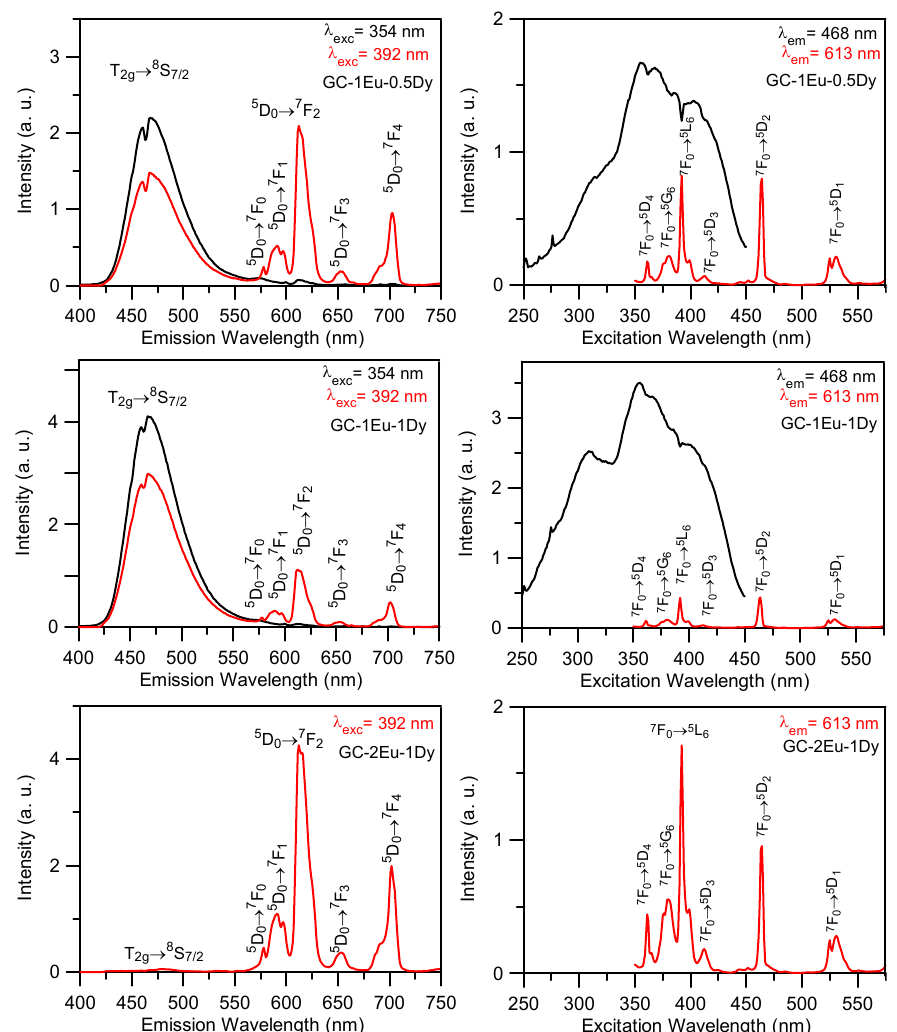
Figure 7. ( Left ) Room temperature emission spectra obtained under excitation at 354 nm (Eu 2+ ) (black line) and 392 nm (Eu 3+ ) (red line) for the GC-1Eu-0.5Dy, GC-1Eu-1Dy and GC-2Eu-1Dy glass- ceramics; ( right ) excitation spectra obtained by collecting the luminescence at 468 nm (black line) and 613 nm (red line).